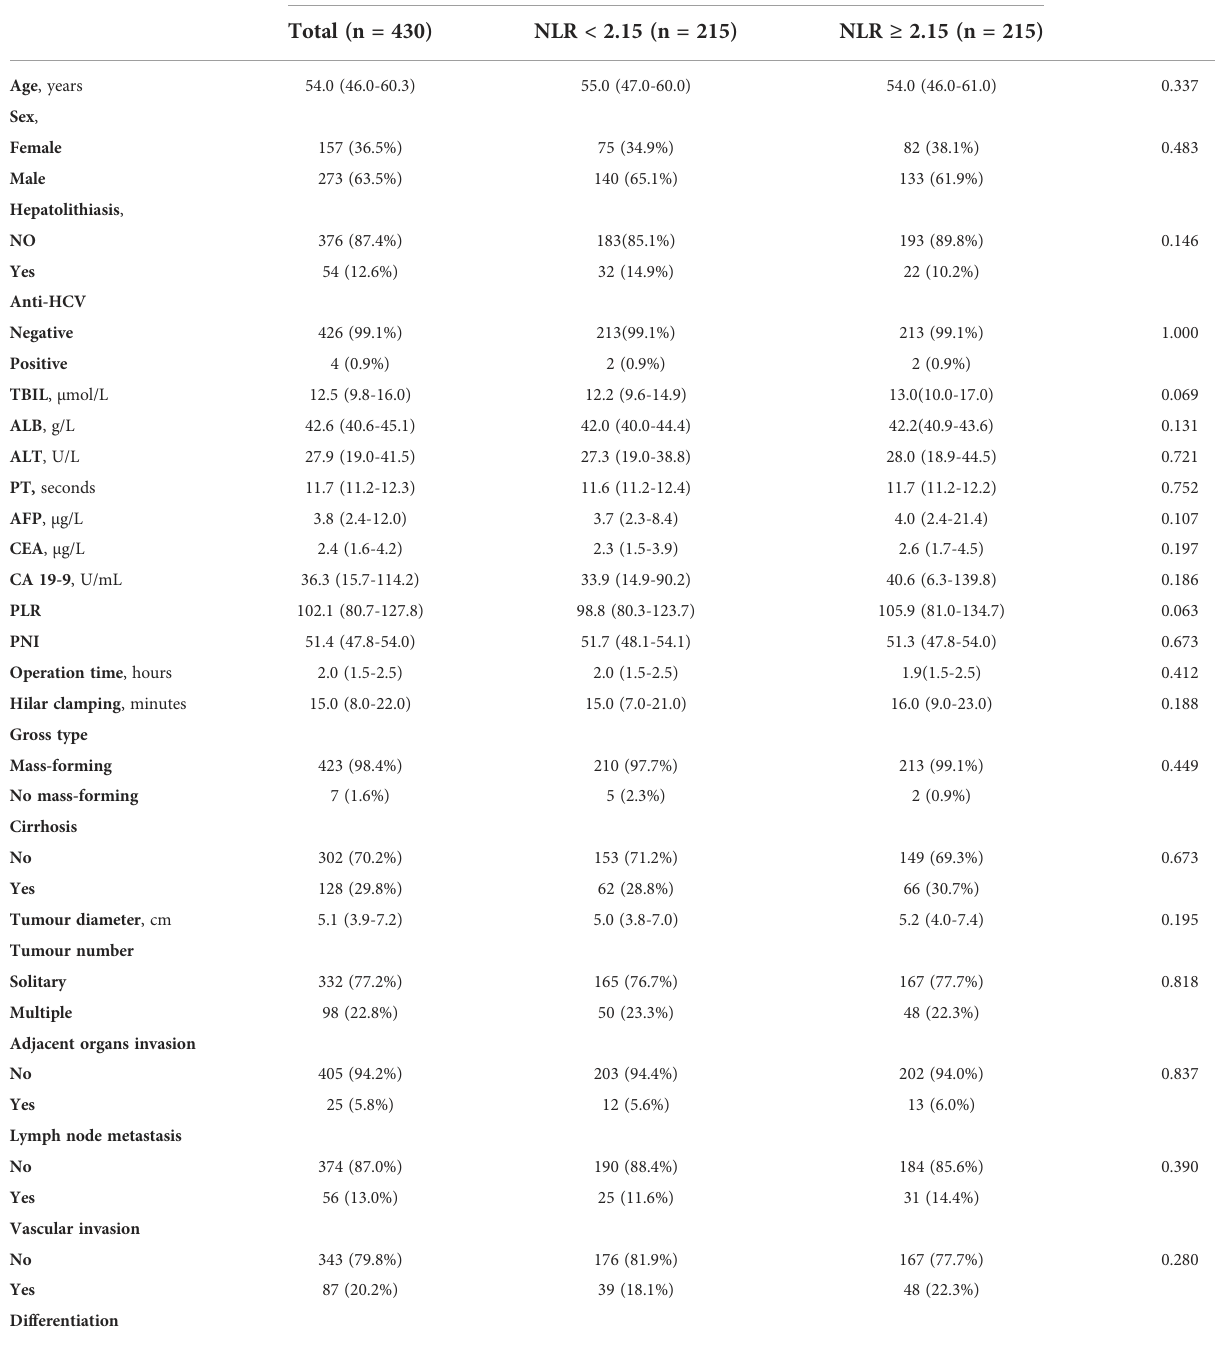
TABLE 6 Baseline clinicopathological data for HBV-ICC Patients in the PSM